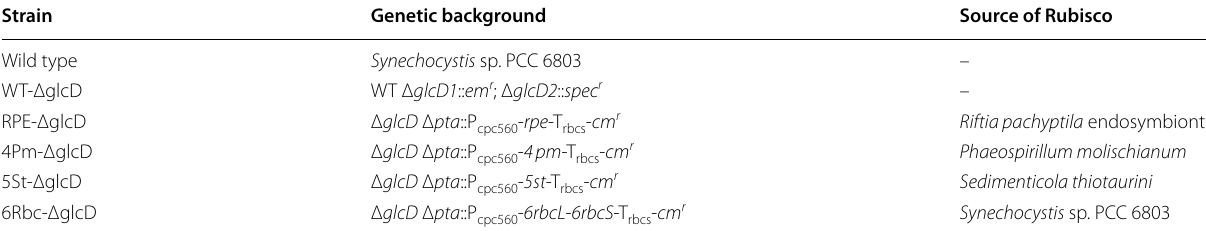
Table 1 The Synechocystis strains used in this study Strain